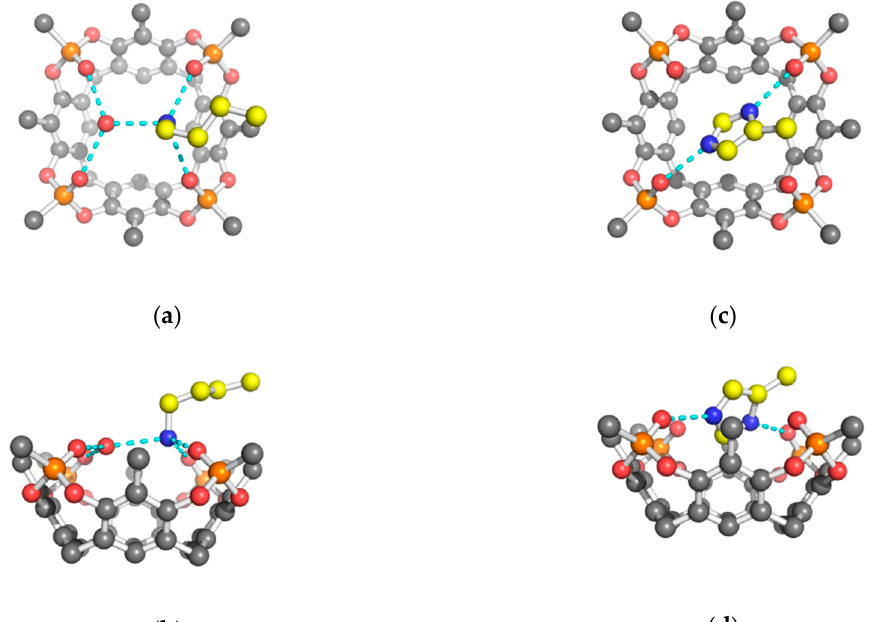
Figure 3. Orthogonal views of the H-bond interactions (cyan dashed lines) between the amino acid side chain (yellow carbons) and tetraphosphonate cavitand (black carbons) ( a , b ) 2 Tiiii[H, CH 3 , CH 3 ] • Lys 2HCl complex; ( c , d ) 2 Tiiii[H, CH 3 , CH 3 ] • His 2HCl complex. Hydrogen atoms have been omitted for